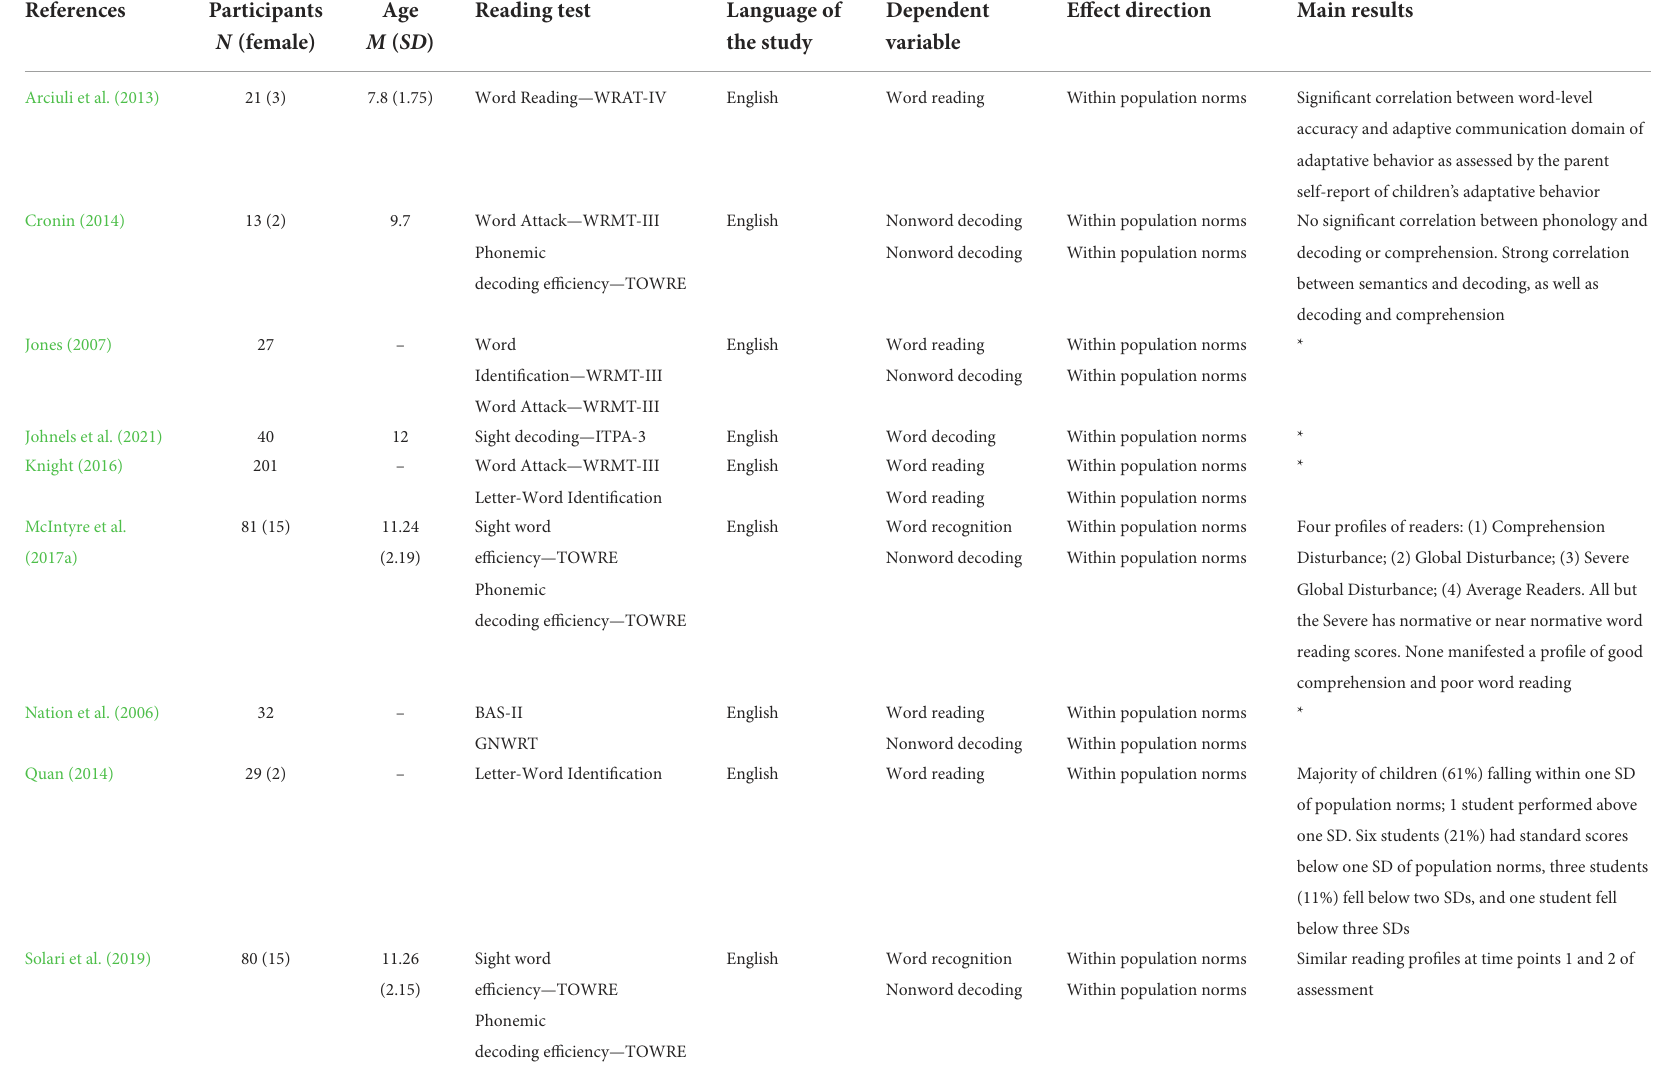
TABLE 3 Results of the studies that compared the performance of children with ASD with normative